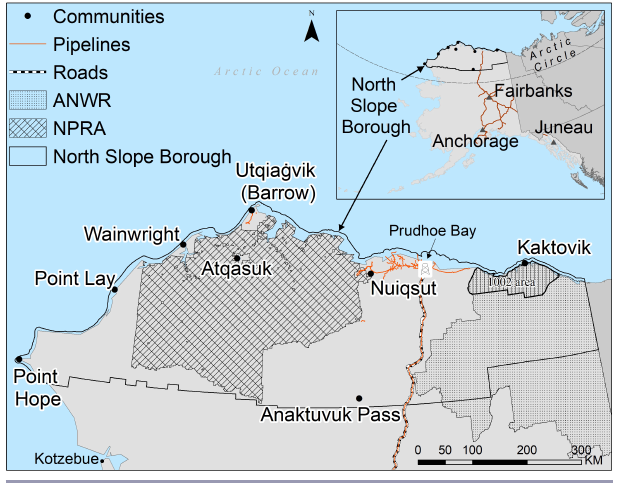
Fig. 2 . The North Slope study region and